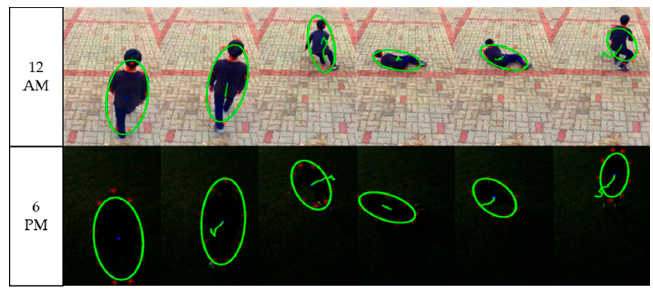
Figure 21. Human tracking results in real illumination variations from midday light (noon) to evening time (6 pm right after sunset) in Korea.